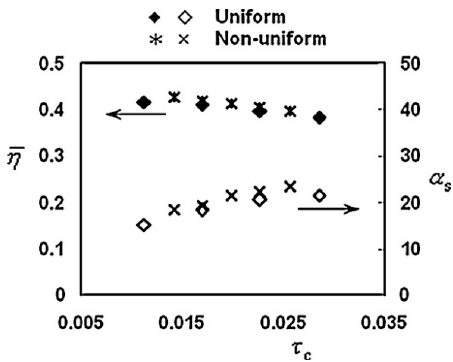
Figure 23. Comparison of mean turbine efficiency and stalling angle between the turbines with uniform and nonuniform tip clearances [52].